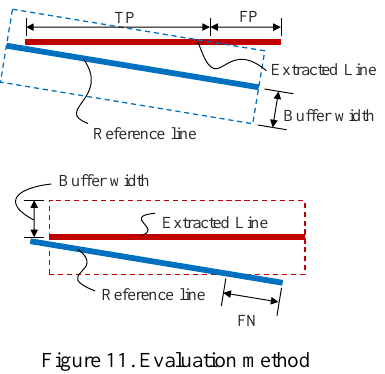
Figure 11. Evaluation